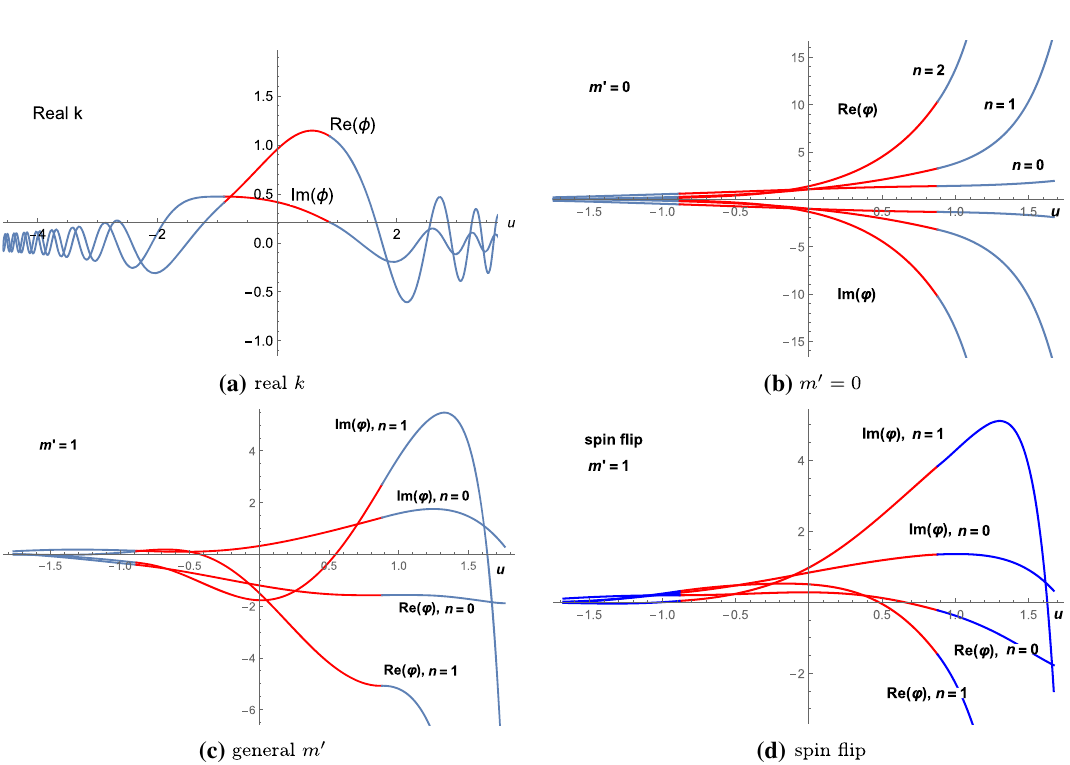
Fig. 7 Wave function profiles of scattering fermion for a real momentum, b m (cid:2) = 0, c general m (cid:2) , and d spin-flip scenario. The real and imaginary parts of the wave functions in the wormhole region u m < u < u p are depicted in